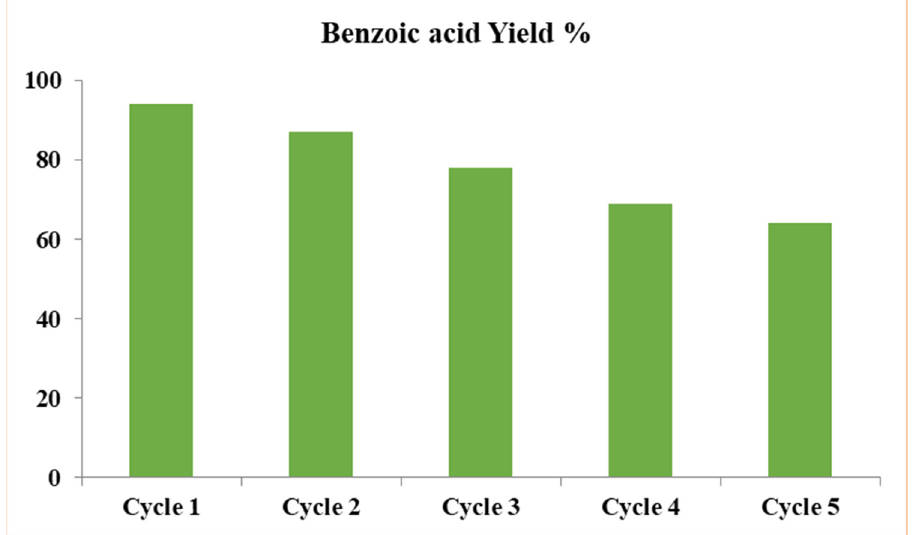
Figure 10. Yield % of benzoic acid in different